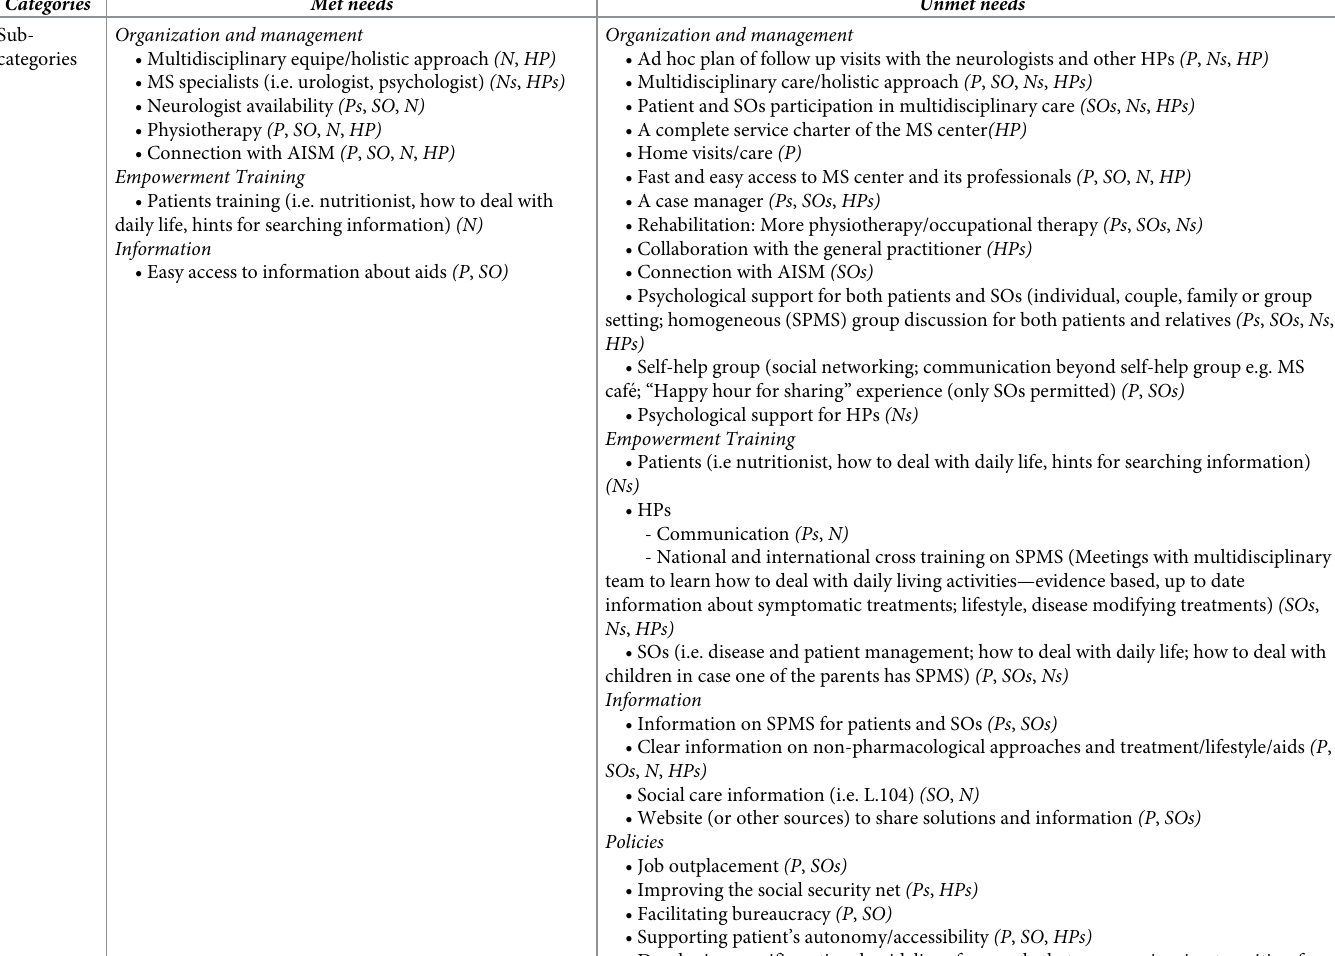
Table 5. Theme 4: Met and unmet needs. AISM, Italian Multiple Sclerosis Society; HP, health professional; MS, multiple sclerosis; N, neurologist; SO, patient significant other; SPMS, secondary progressive multiple sclerosis; RRMS, relapsing remitting multiple